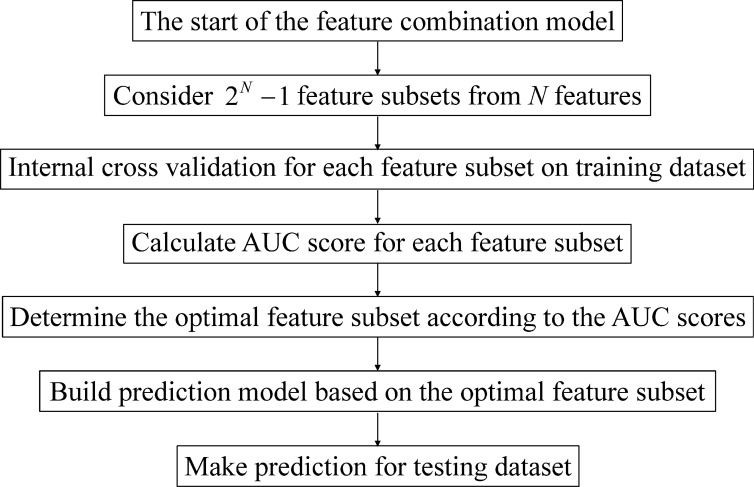
The flowchart of the feature combination model.